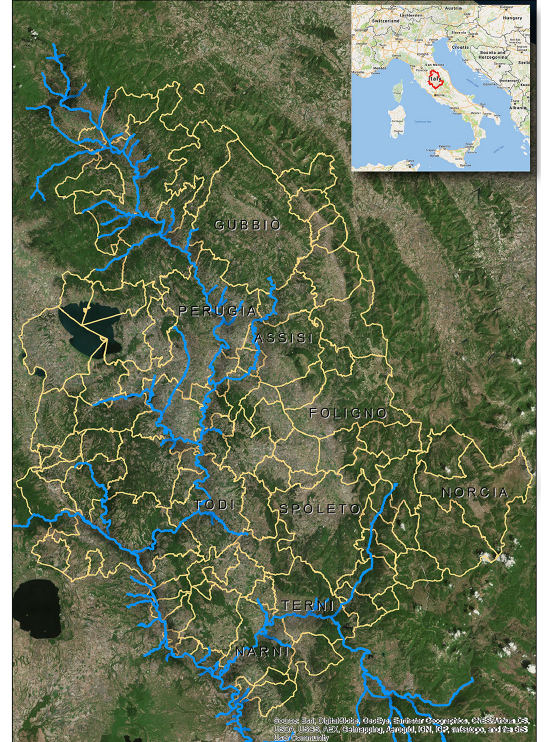
Figure 1. The case study area.